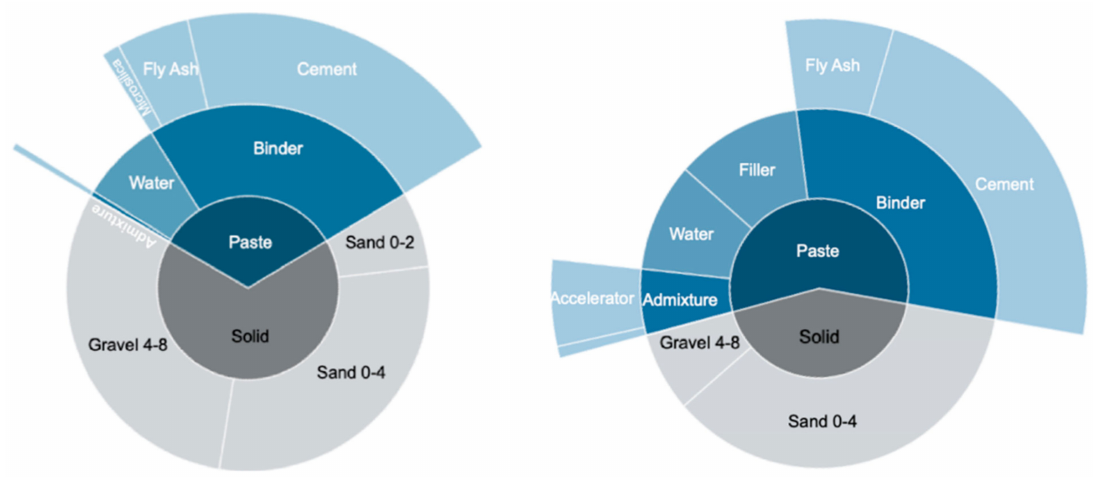
Figure 14. Industry mix composition ( left ) and optimized ETH mix composition ( right